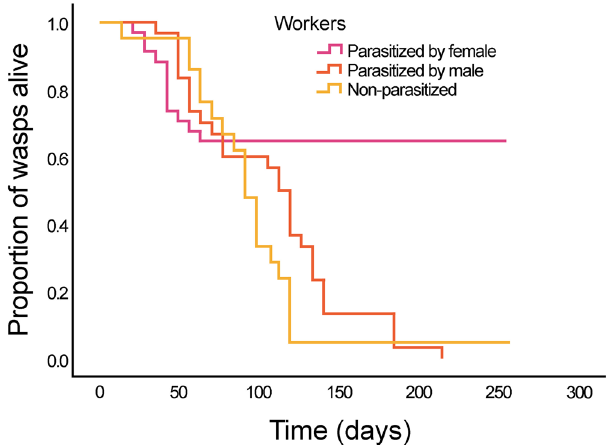
Figure 1. Survival rate of workers parasitized by a X. vesparum female (blue, n = 34), by a X. vesparum male (red, n = 30) and non-parasitized workers (green, n = 21) from July until March. Kaplan–Meier plot (Log Rank test, p < 0.001).